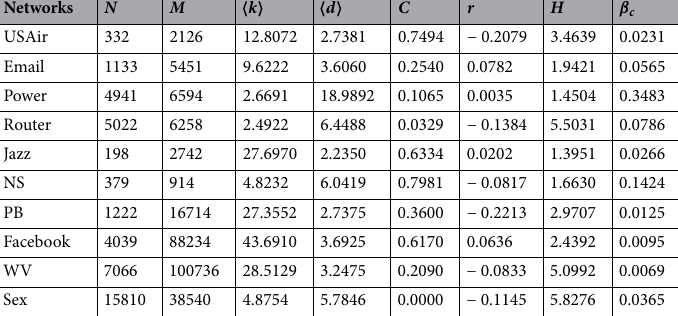
Table 3. The topological features of ten real